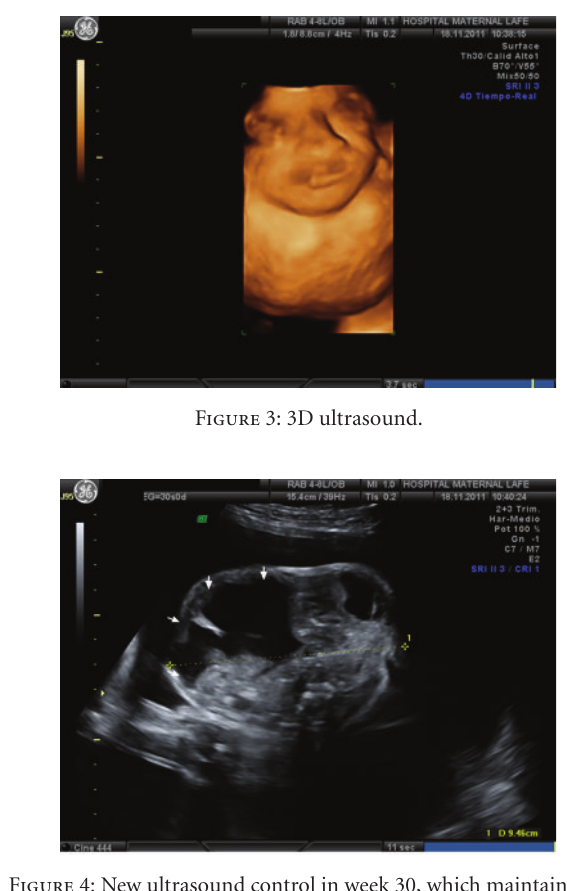
Figure 4: New ultrasound control in week 30, which maintains the increased tumor size (arrows) and heterogeneous